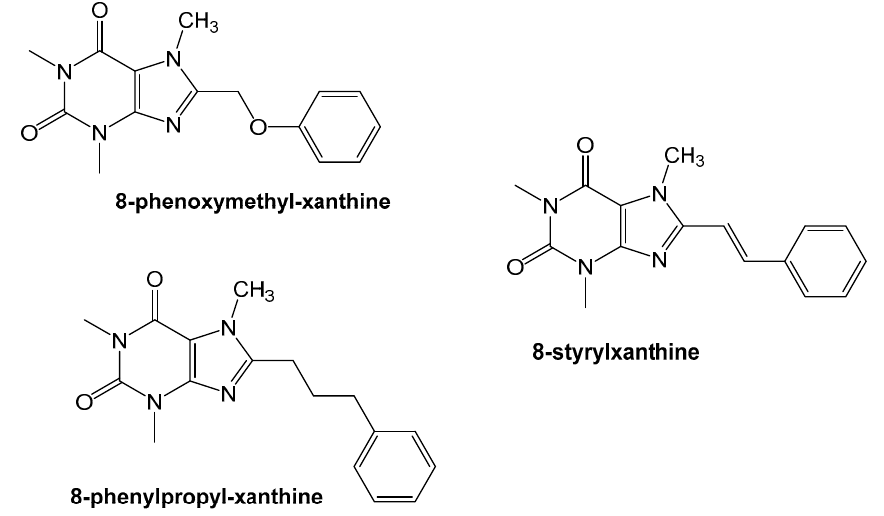
Figure 7. The styrylxanthine scaffold is preferred for A 2A receptor binding when compared to the phenoxymethyl or phenylpropyl xanthines [31].